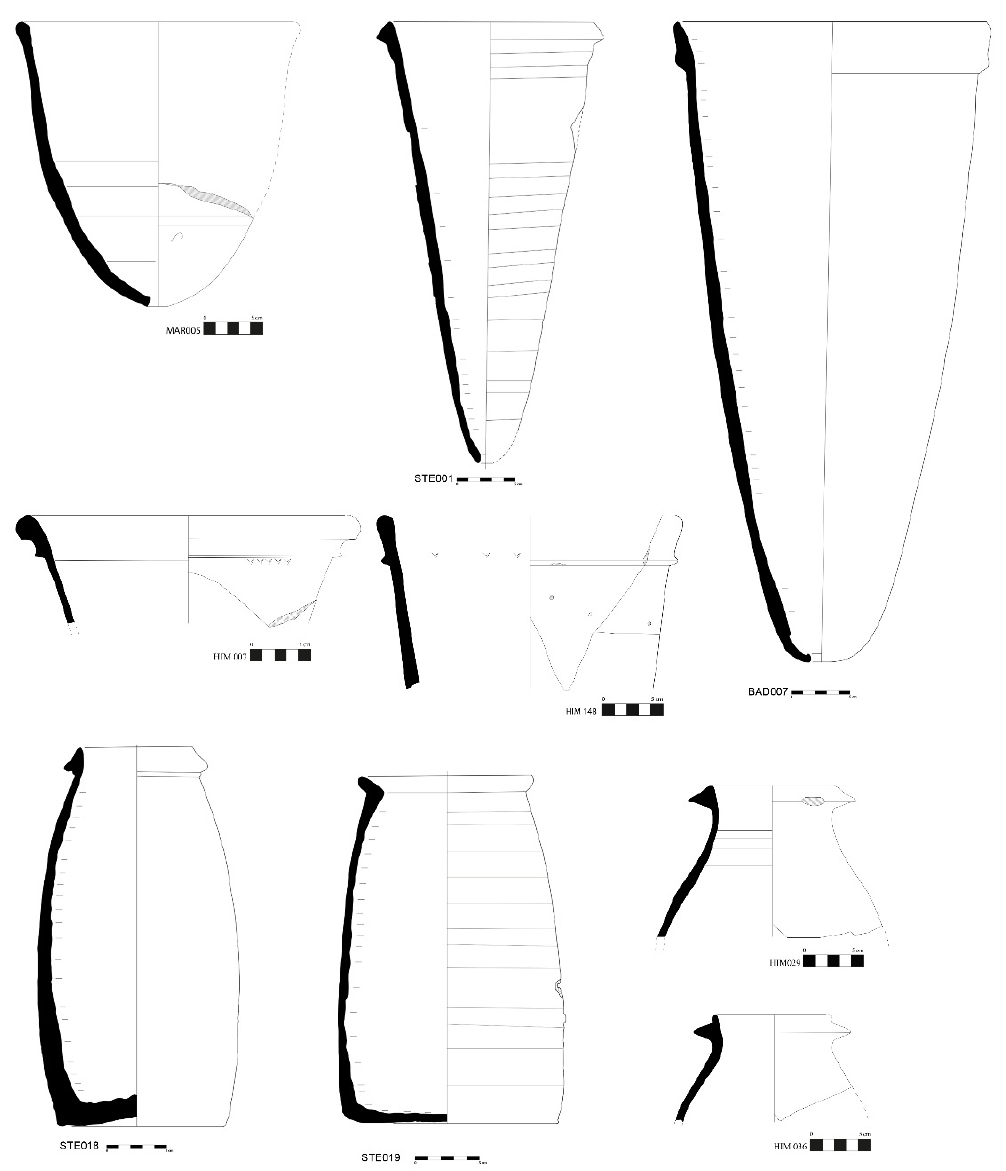
Figure 3. Representative sugar cones and molasses jars for each type: sugar cone type 1 (MAR005), type 2 (STE001), type 3 (BAD007), type 4 (HIM007), type 5 (HIM148); molasses jar type A.1 (STE018), type A.2 (HIM029), type A.3 (HIM036), type B (STE019). (Drawings of STE001, BAD007, STE018 and STE019 by S. Arrabito, others by R.